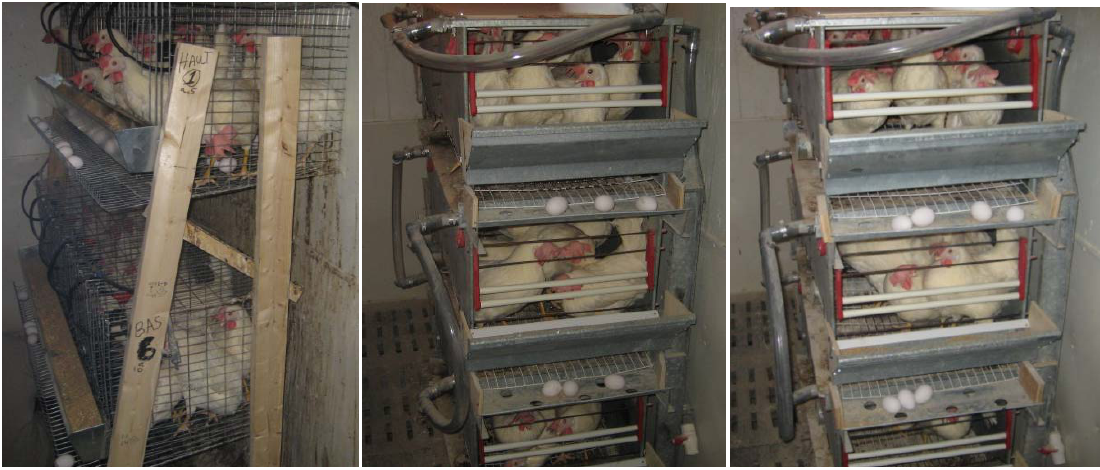
Figure 2. Deep liquid manure pit system (left) and manure belt systems with natural (center) and forced air drying